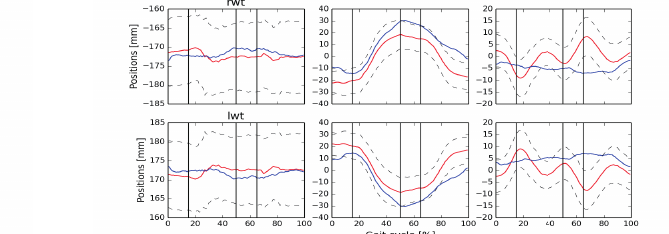
Figure 8: Comparison of shoulder positions